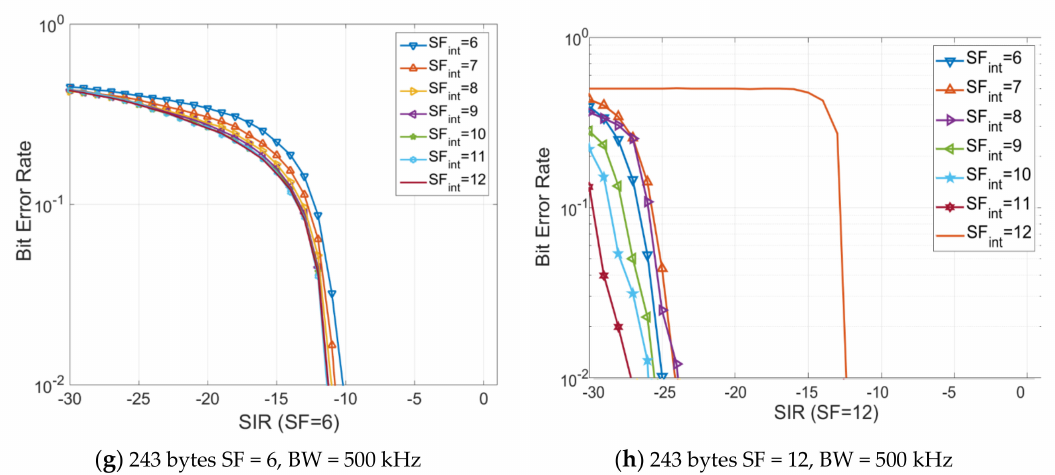
Figure 4. The analysis of performance based on SF, BW and packet payload variation. The SF is varied from SF6 to SF12 and the bandwidths analyzed are 125 kHz and 500 kHz, respectively. In the evaluation scenarios, the payload is varied from 1 byte to 243 bytes.